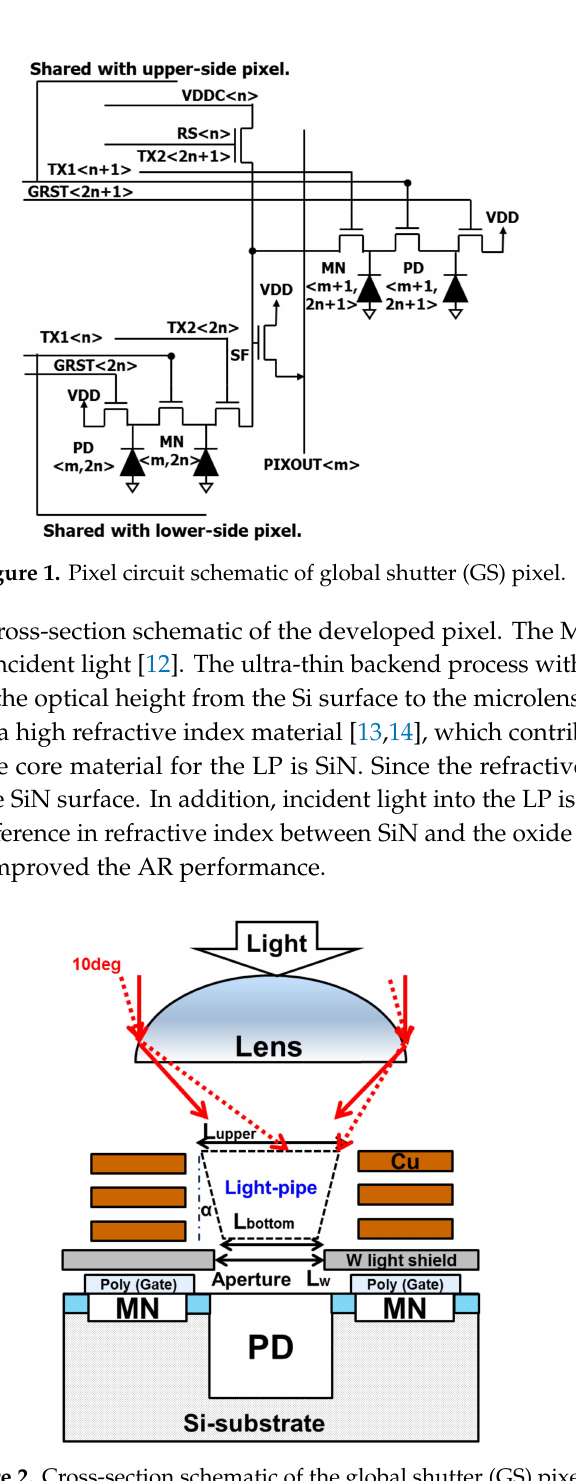
Figure 2. Cross-section schematic of the global shutter (GS)